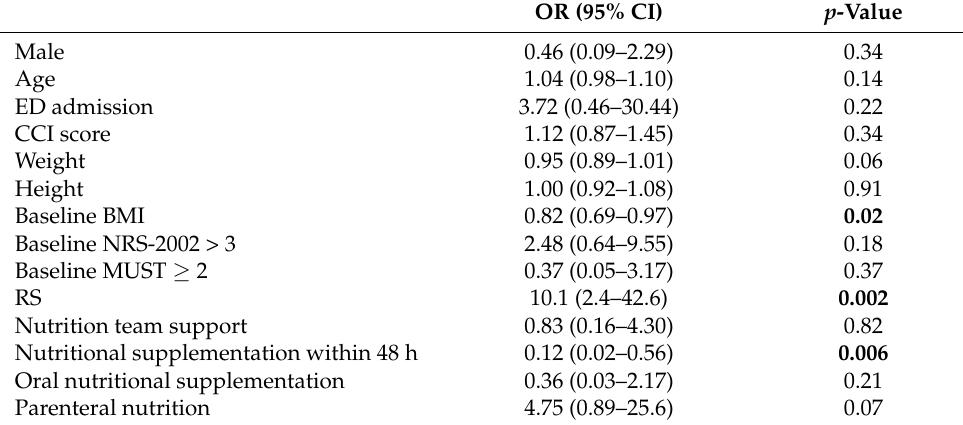
Table 4. Univariate analyses of risk factors associated with in-hospital mortality ( n =